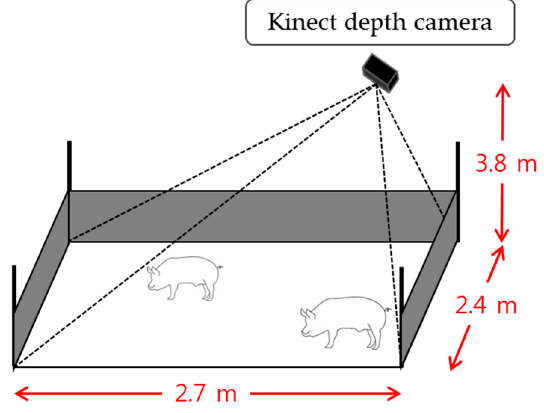
Figure 15. Experimental setup with a Kinect depth camera.